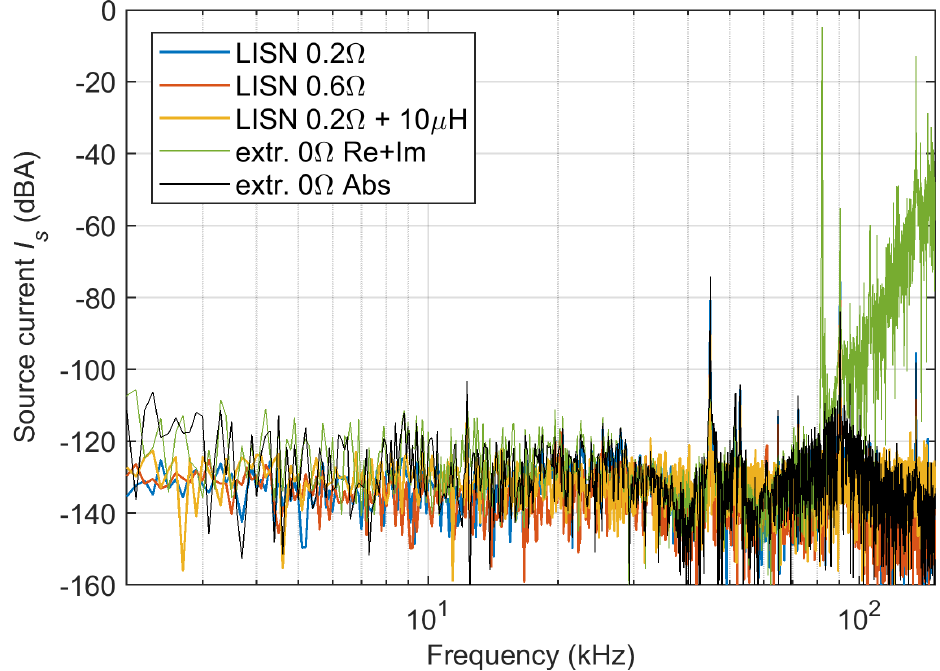
Figure 7. Extrapolation of measured I s current to the 0 Ω